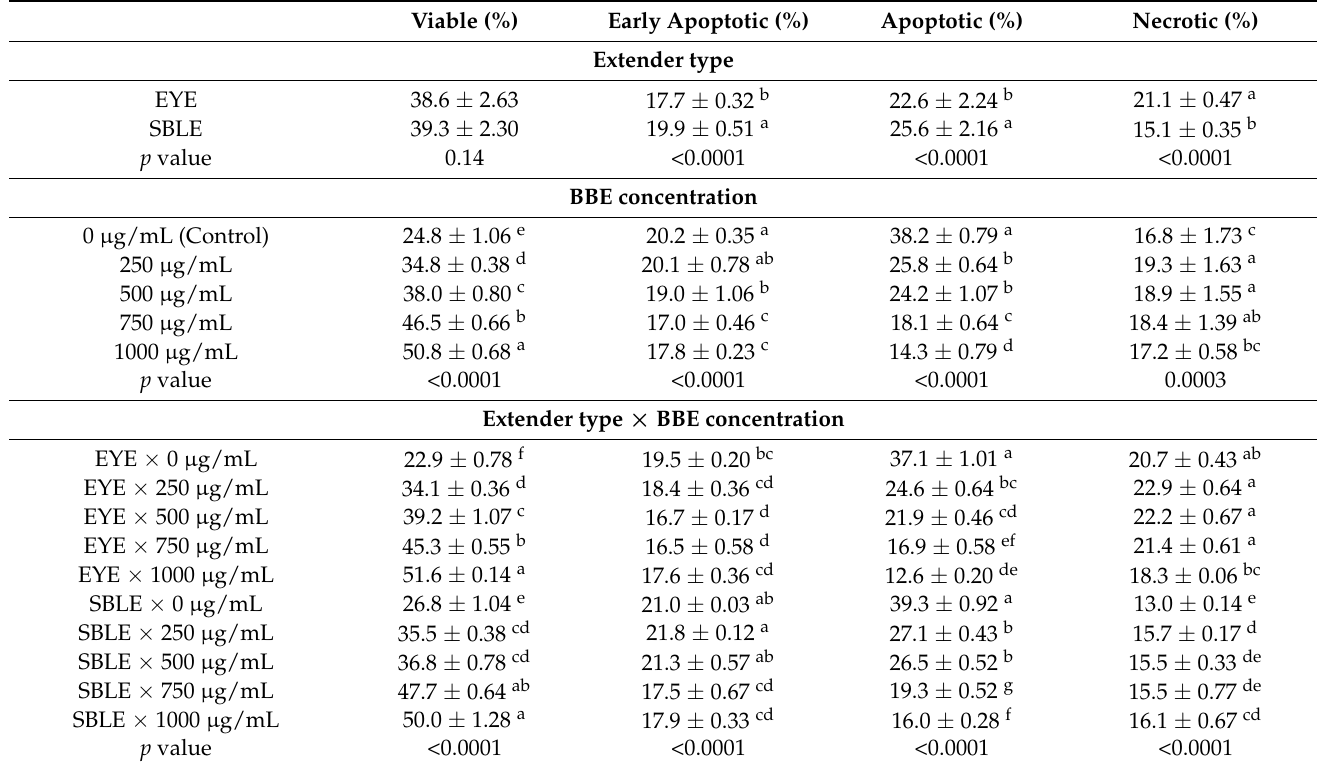
Table 7. Effects of the extender type, bee bread extract (BBE) concentration, and their interaction on the percentage of viable, early apoptotic, apoptotic, and necrotic sperm in ram semen after thawing using Annexin V/propidium iodide